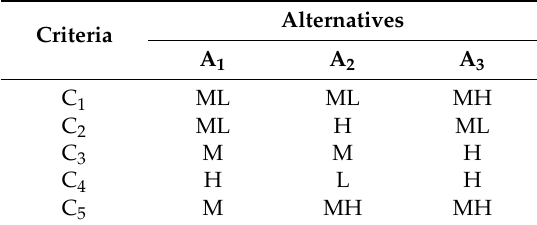
Table 9. Linguistic decision matrix.